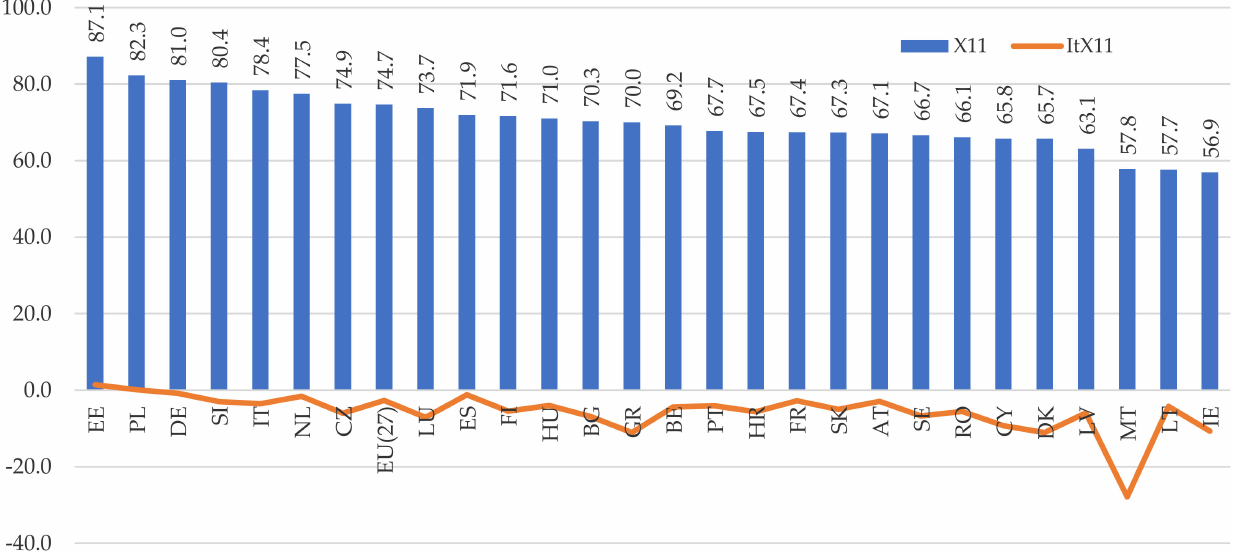
Figure 4. A ranking of EU (27) countries according to greenhouse gas emissions from energy (X 11 ) in 2019 and index I tX11 for 2019 (2010 = 100). Source: own work based on